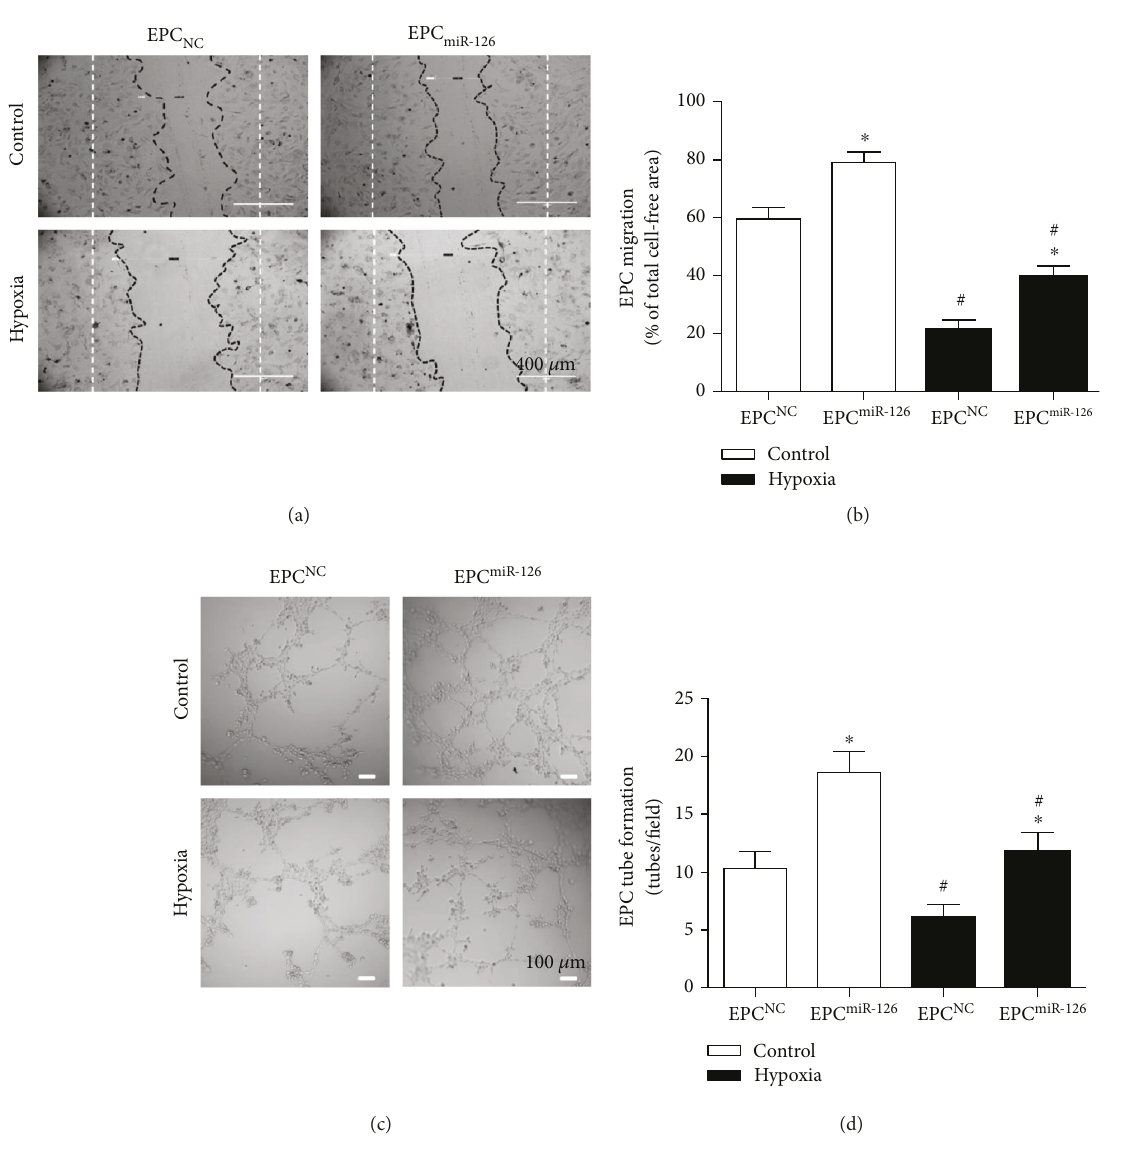
Figure 2: E ff ects of miR-126 overexpression on the migration and tube formation of EPCs and hypoxia-injured EPCs. (a) Representative image of EPC migrations. Scale bar: 400 μ m. (b) Summarized data on migration of EPCs. (c) Representative image of EPC tube formation. (d) Summarized data on tube formation. ∗ p < 0 05 versus EPC NC ; # p < 0 05 versus control, n = 3